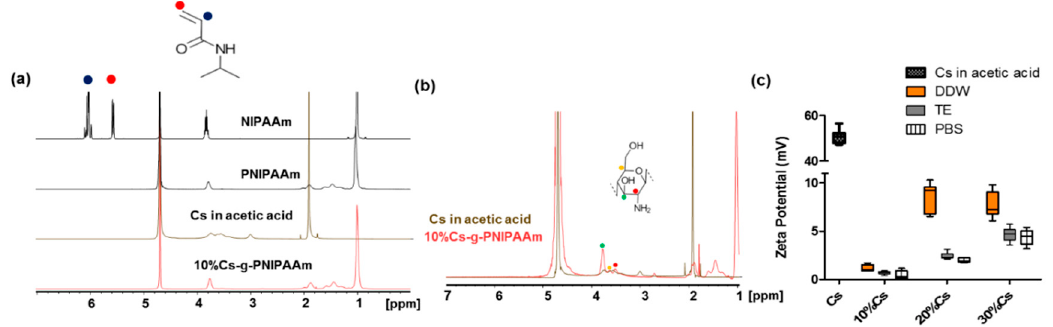
Figure 2. Verification of Cs-g-PNIPAAm composition via ( a ) 1 H-NMR spectra of NIPAAm monomer, PNIPAAm, Chitosan in 1% acetic acid, and Cs-g-PNIPAAm copolymer; ( b ) comparison of Cs in acetic acid and Cs-g-PNIPAAm copolymer. 1 H-NMR confirmed presence of PNIPAAm and chitosan in the